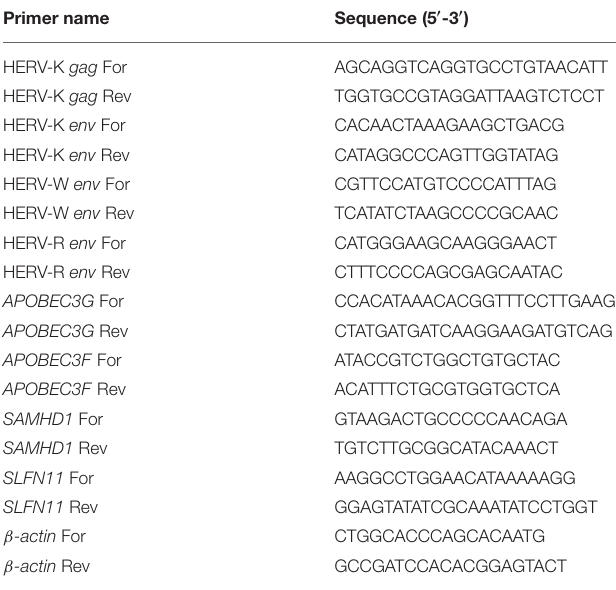
TABLE 1 | List of primers used for real time